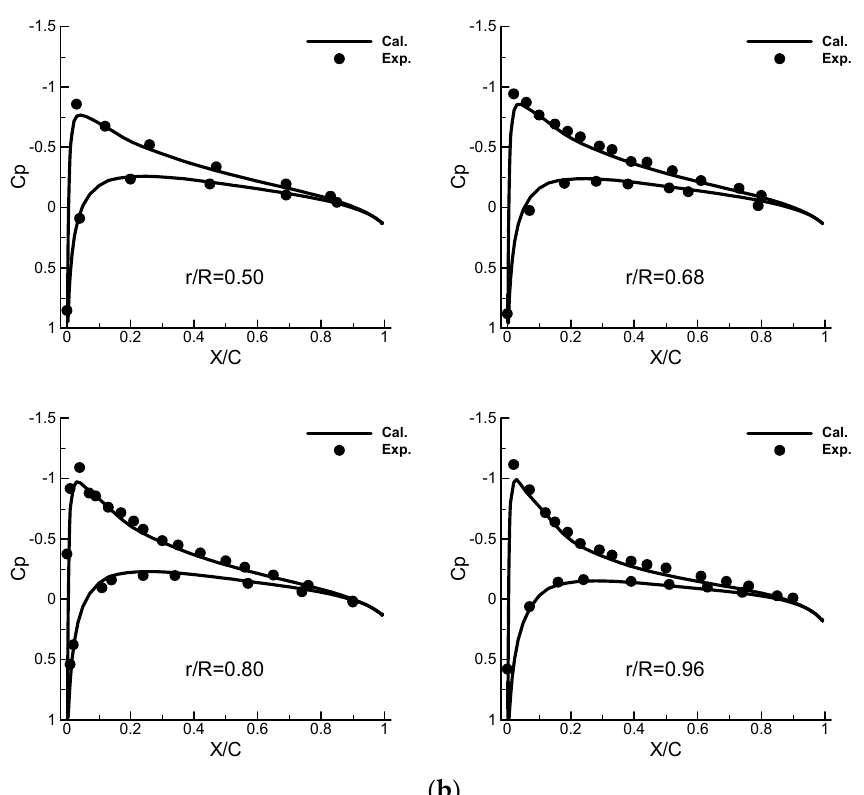
Figure 3. Comparison with experiments on Caradonna—Tung pressure distribution. ( a ) M tip = 0.44, θ c = 2 deg, ( b ) M tip = 0.44, θ c = 8 deg .